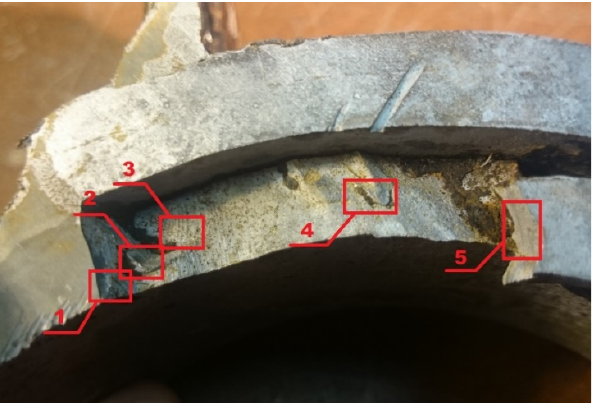
Figure 15. Fracture surface: Areas 1 to 5 are used for fractographic analysis.